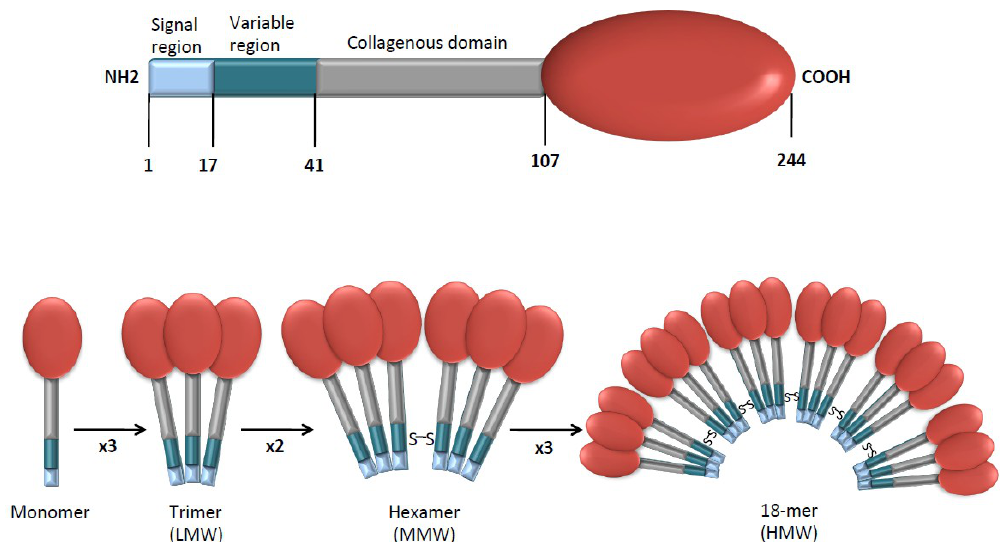
Figure 1. APN's molecular structure and isoforms. Monomeric APN is able to trimerize to form low molecular weight (LMW) APN. Two trimers can then combine to form middle molecular weight (MMW) hexamers. The trimers are able to form 12- or 18-mers with high molecular weight (HMW). After post-translational modifications, APN circulates in trimeric, hexameric, and multimeric high-molecular weight (HMW) isoforms. Each isoform is able to activate distinct signal transduction